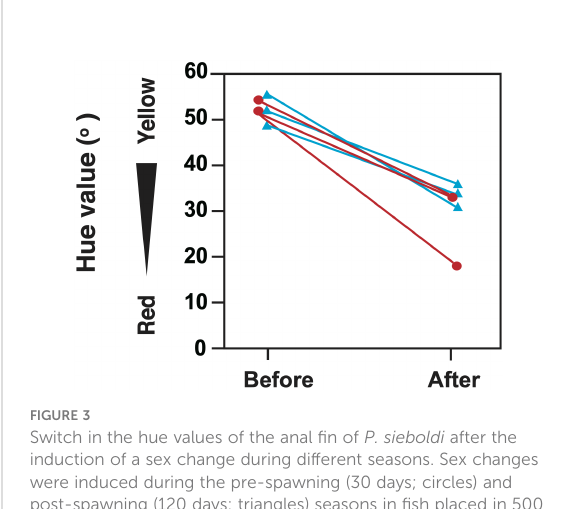
FIGURE 3 Switch in the hue values of the anal fi n of P. sieboldi after the induction of a sex change during different seasons. Sex changes were induced during the pre-spawning (30 days; circles) and post-spawning (120 days; triangles) seasons in fi sh placed in 500 L tanks (n =